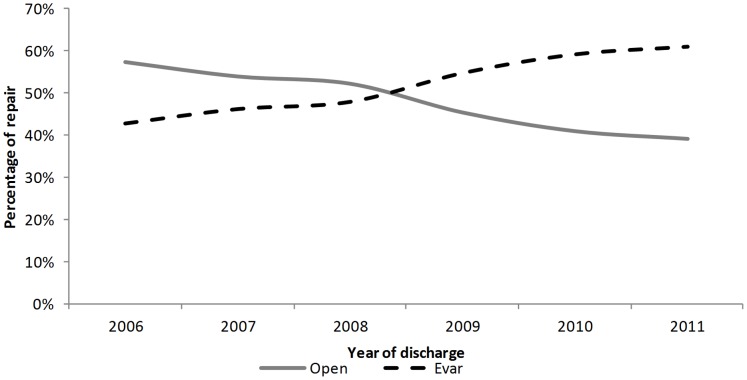
Percentage of OSR/EVAR in uAAAs.